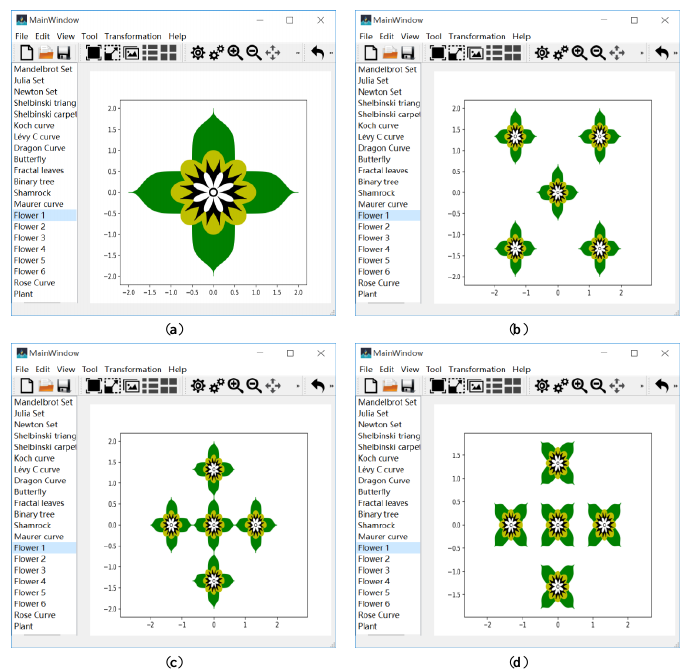
Figure 14. Basic flower pattern and flower layout patterns. ( a ) Basic flower pattern; ( b ) flower layout pattern with X-axis displacement of 4/3 and X-axis displacement of 4/3; ( c ) flower layout pattern with X-axis displacement of 4/3; ( d ) flower layout pattern with X-axis displacement of 4/3 and rotation of 45°.